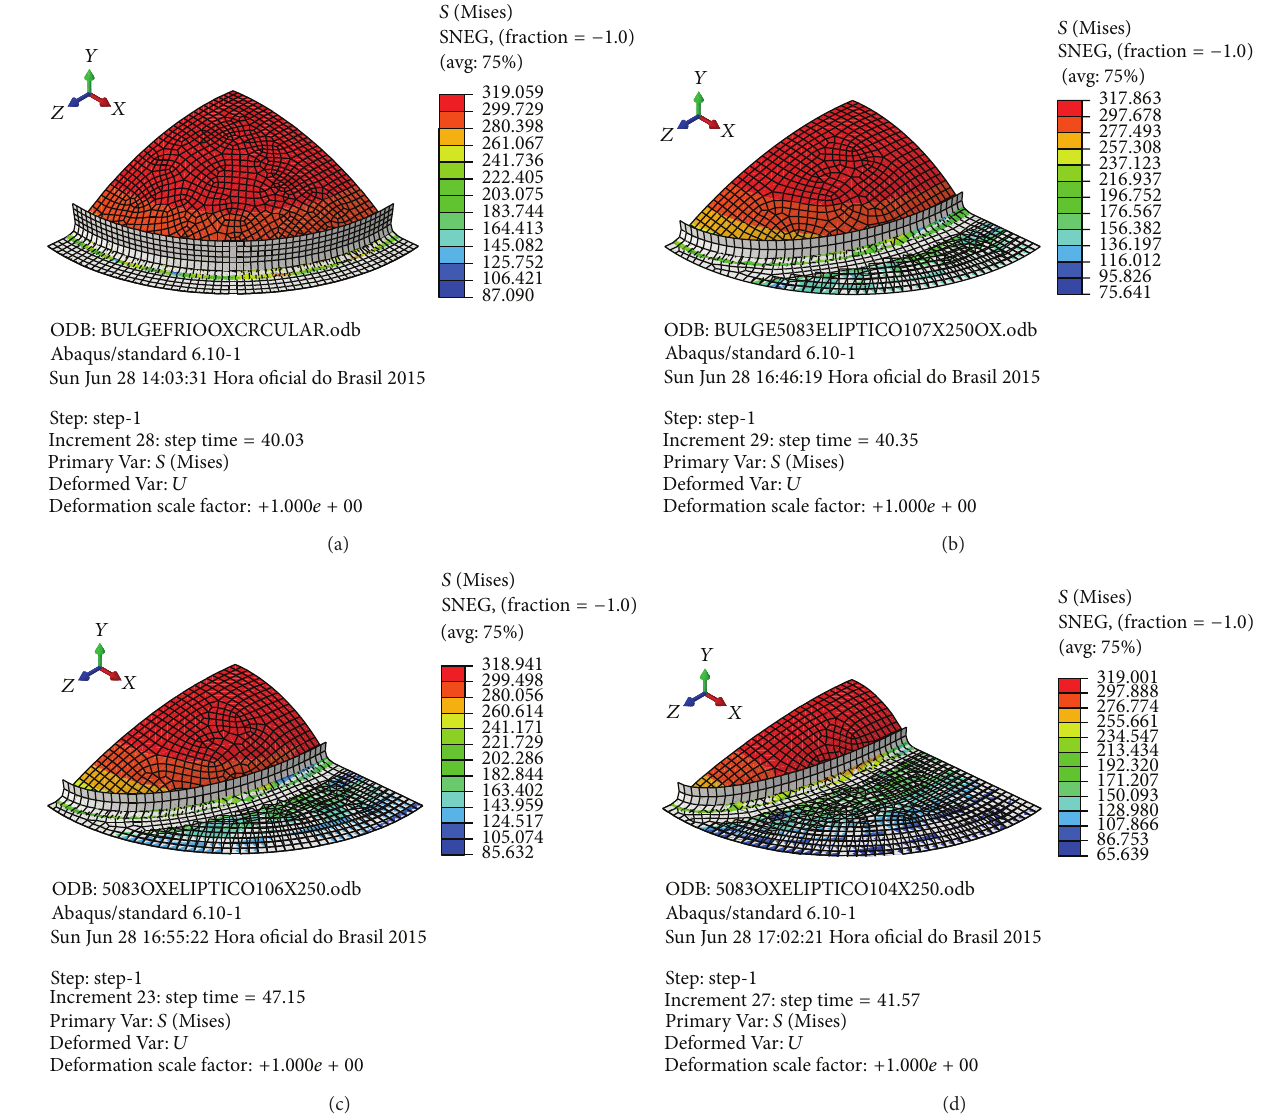
Figure 26: Von Mises stress distribution for the CS1 condition in Abaqus. (a) Circular. (b) 10 × 7 ellipse. (c) 10 × 6 ellipse. (d) 10 × 4 ellipse.